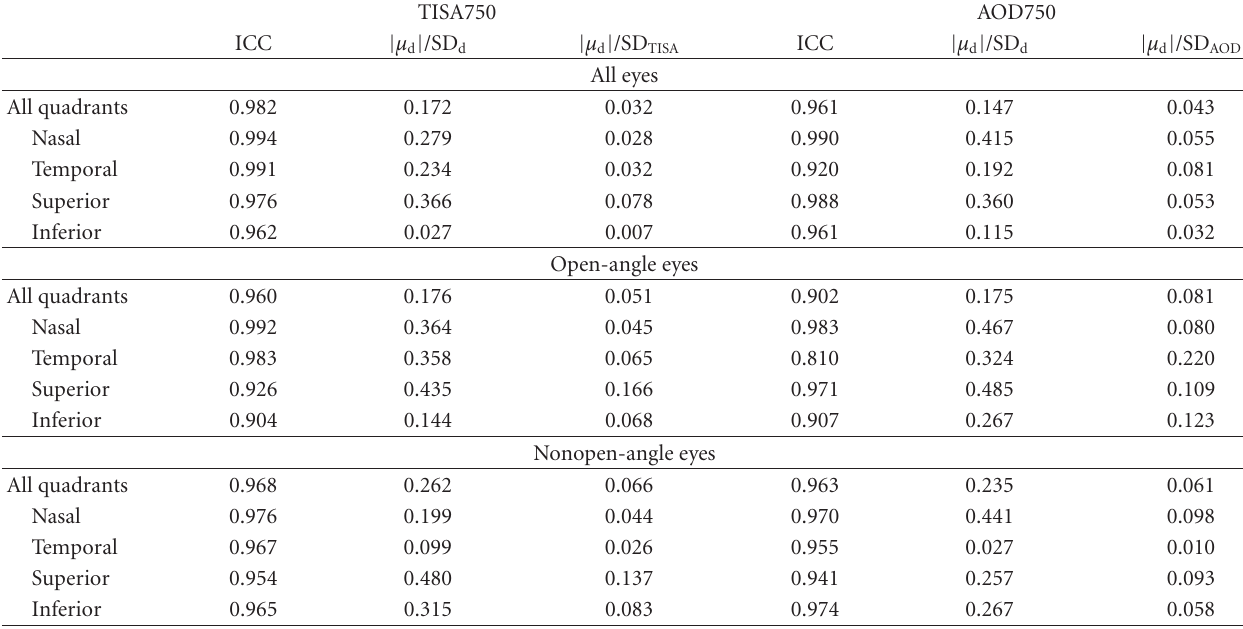
Table 4: Intraobserver correlation coe ffi cient (ICC) for TISA750 and